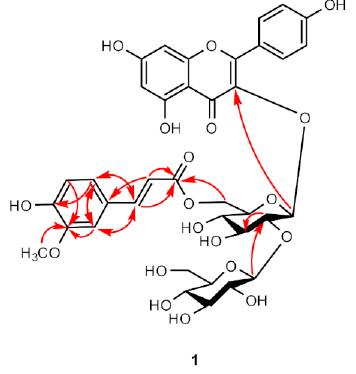
Figure 5. Key HMBC correlations of 1